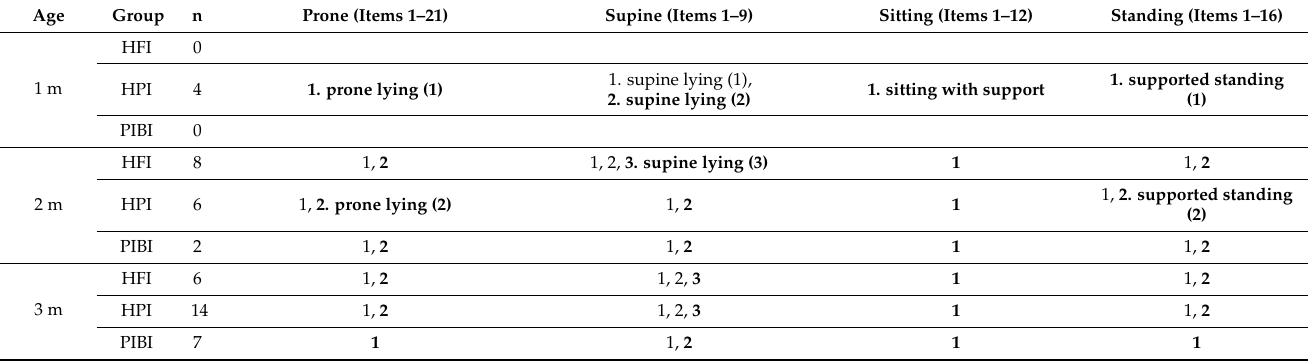
Table 4. Motor repertories and representative motor skills through 1–12 months using AIMS (n =